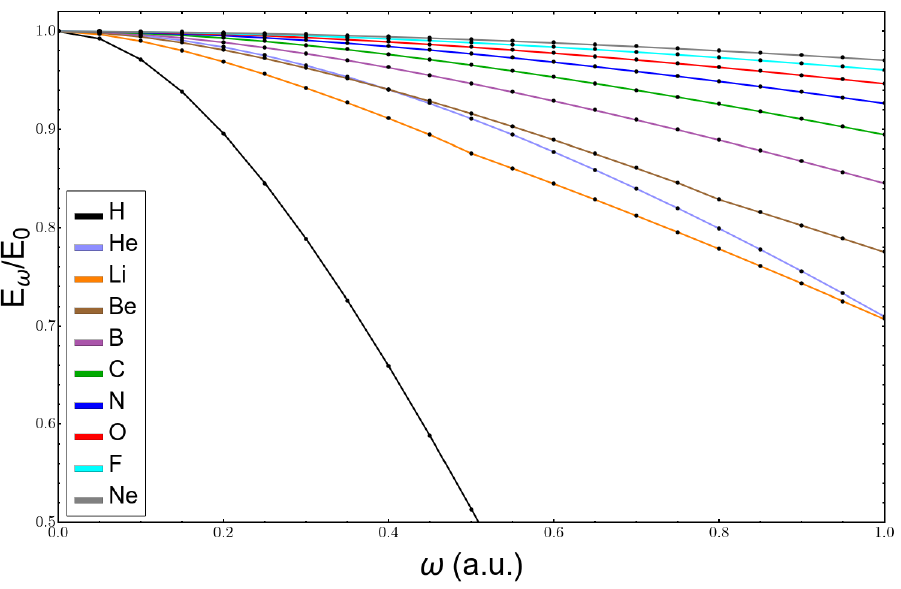
Figure 1. Variation of the ratio between the total energy of atoms from H to Ne at confinement ω and the total energy of their free counterpart with